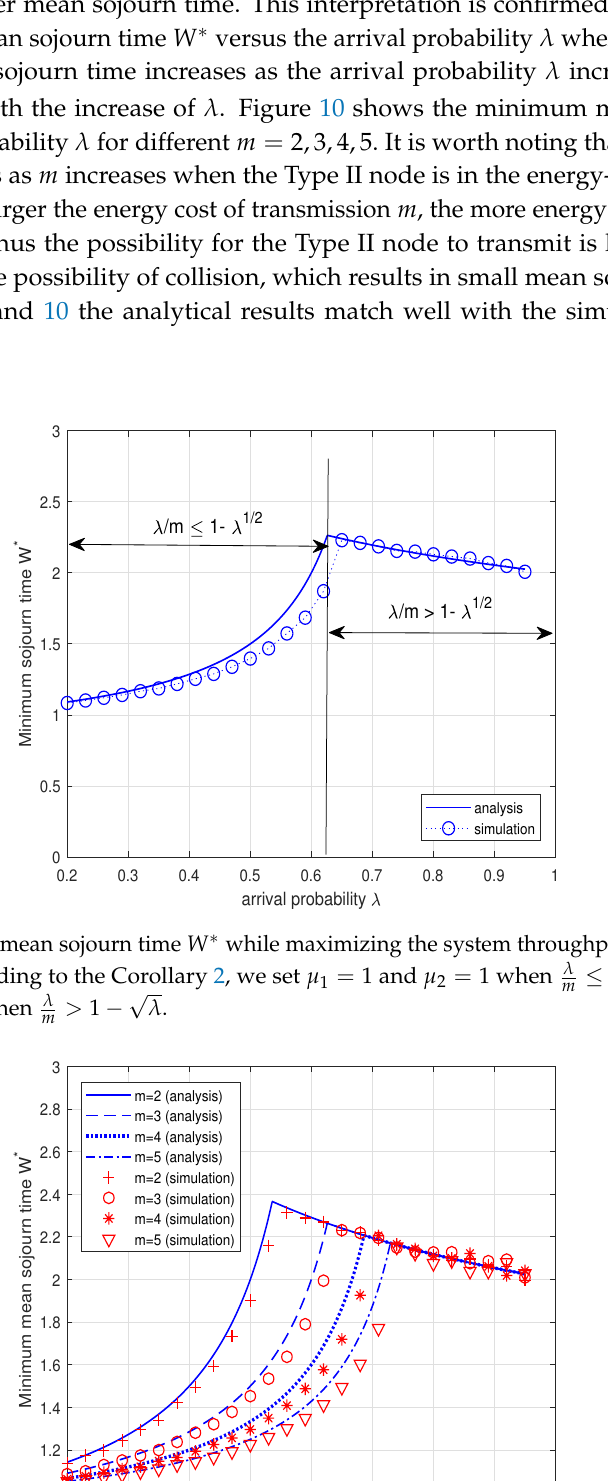
Figure 10. Minimum mean sojourn time W ∗ while maximizing the system throughput versus λ for different m = 2,3,4,5. According to the Corollary 2, we set µ 1 = 1 and µ 2 = 1 when λ µ 1 = 1 and µ 2 = 1 −